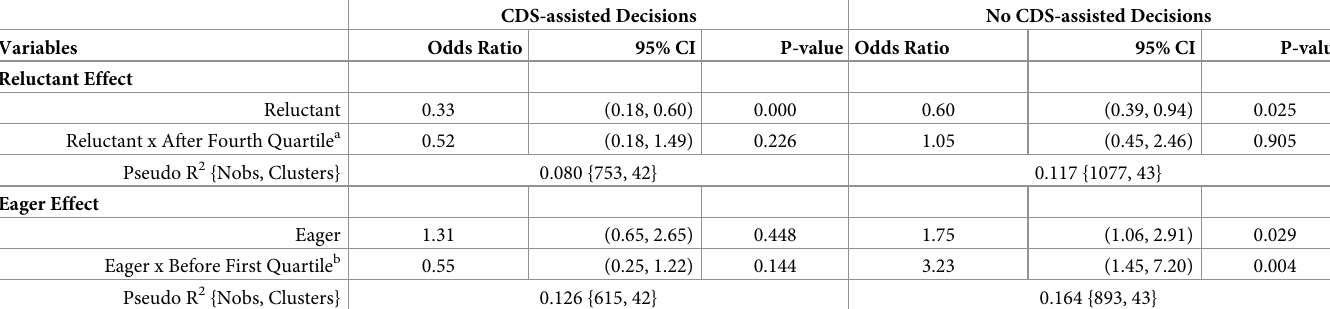
Table 4. Patient preference effects on discharge decisions according to logistic